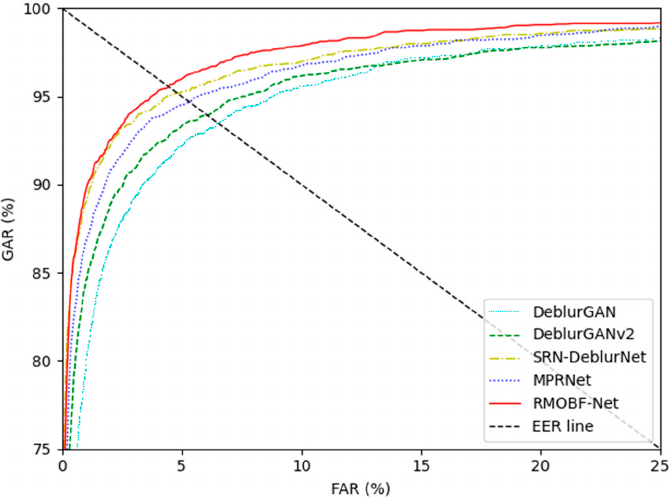
Figure 19. ROC curves of finger-vein recognition with SDU-DB for scheme 4 by various restoration methods (random motion blur and optical blur with intensity 15 × 15 (Gaussian filter size) and 15 (Gaussian filter standard deviation)).